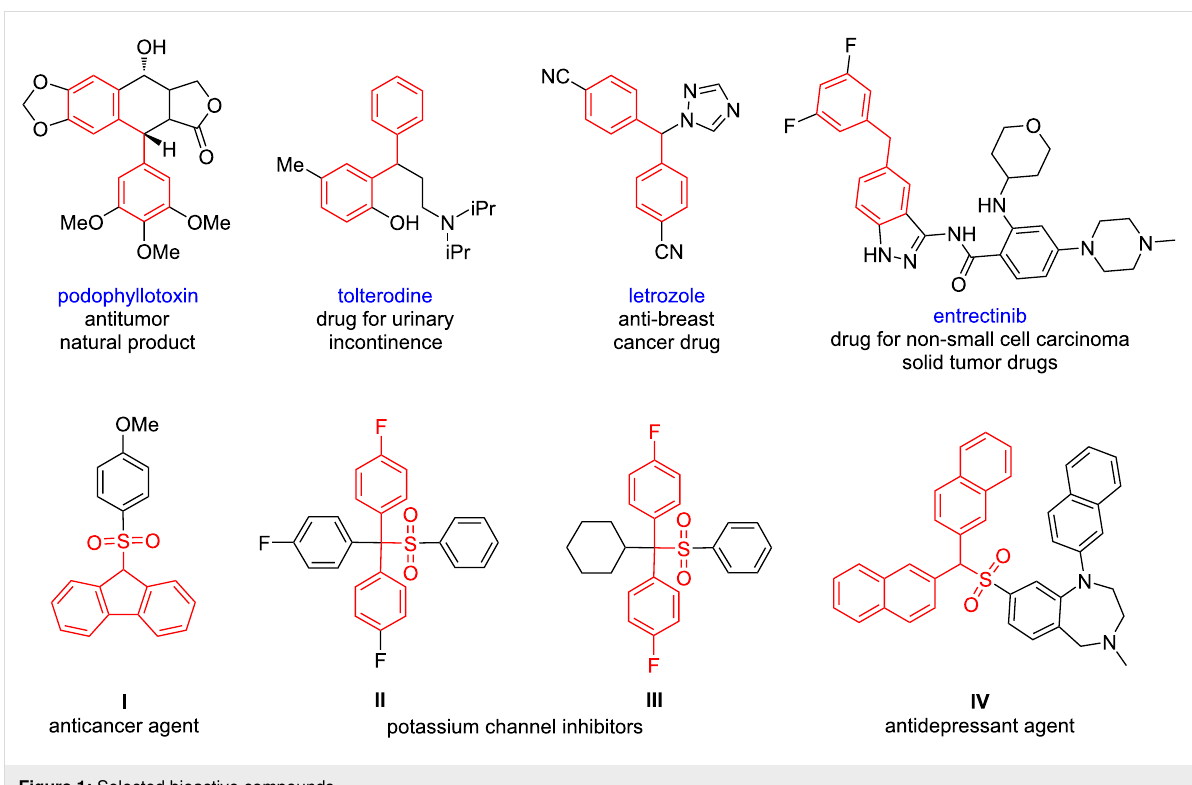
Figure 1: Selected bioactive